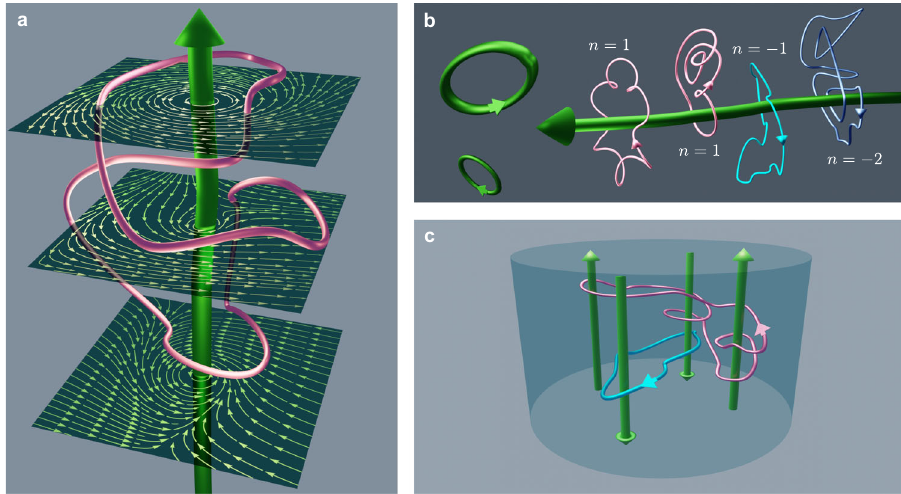
Fig. 1 Vizualizations of tracer particle trajectories in vortex force- fi elds. a A tracer particle undergoes diffusion and drift in a force- fi eld whose non- conservative component is generated by a vortex line (thick green), tracing out a stochastic trajectory (thin irregular loop). The force- fi eld has the same rotational component throughout but varying irrotational components (the cross-sections depict force- fi eld streamlines) — however, closed loops pick up only the rotational component. b Different particle trajectories around a single vortex line (green) can be characterized by the winding number n . The leftmost two are topologically equivalent with n = 1, while the rightmost two have the opposite sign and winding numbers n = − 1 and n = − 2, respectively. c Force- fi elds can contain multiple vortex-cores (thick green lines or rings), around which particles can trace closed trajectories (thin irregular